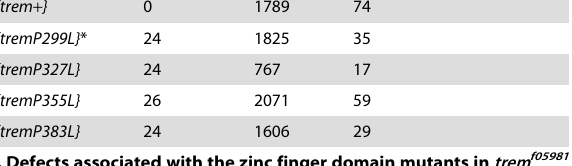
We mutated the second cysteine in each of these conserved blocks in trem and expressed the mutant construct under the native promoter as we had done with all the other site-directed mutations. We were unable to detect the presence of the mutated Trem protein in a trem f05981 background by immunofluorescence for either construct (see Figure S3), which may mean either that the altered protein is no longer recognized by the polyclonal guinea pig anti-Trem antibody, or that these mutations have caused the protein to be targeted for degradation. Perhaps not surprisingly, neither mutant construct was able to rescue the sterility phenotype associated with the trem f05981 mutation (data not shown). Since the promoter region was unchanged from the other site-directed mutant constructs (all of which expressed proteins identified by the polyclonal antibody), there is no reason to speculate that the gene is not expressed. Future studies will be needed to determine what role the ZAD plays in the function of Trem during female meiosis.